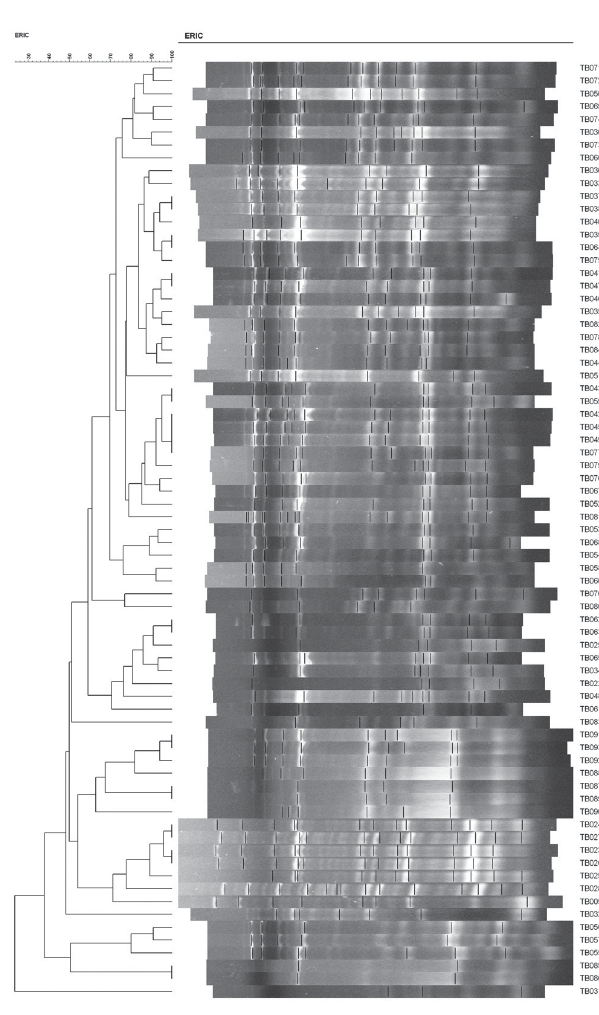
FIGURE 3 - Combined numerical analysis of Mycobacterium tuberculosis clinical isolates from southwestern, Paraná, Brazil, using Enterobacterial Repetitive Intergenic Consensus sequence (ERIC-PCR). The dendrogram was obtained using the BioNumerics software (version 4.45; Applied Maths, Sint- Martens-Latem,